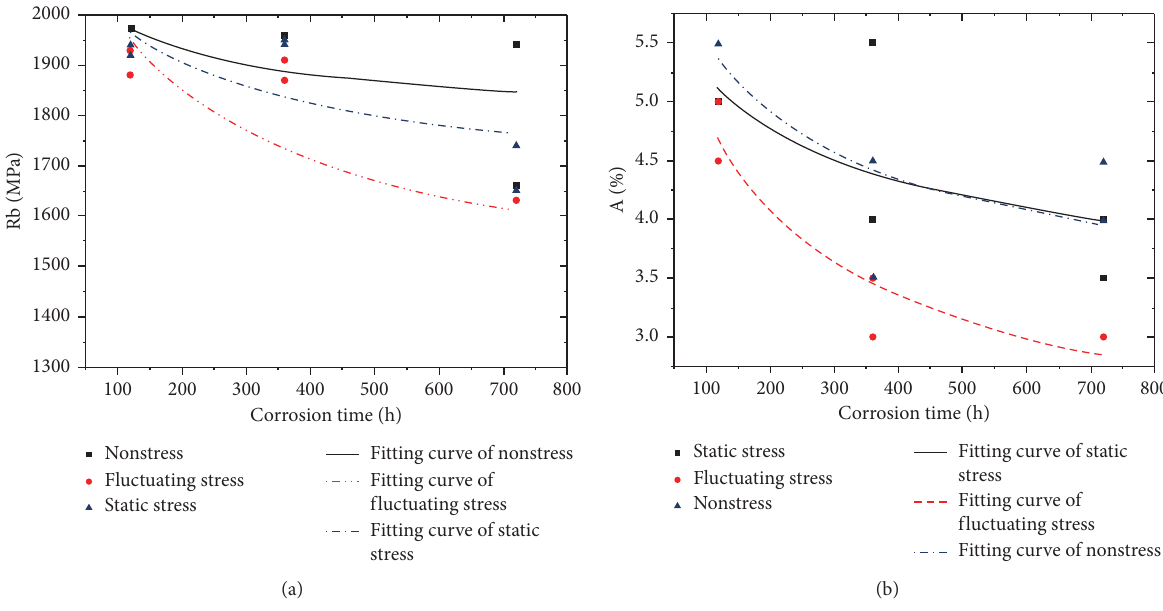
Figure 9: Mechanical parameters under different loading conditions [19]: (a) breaking strength Rb; (b) elongation A